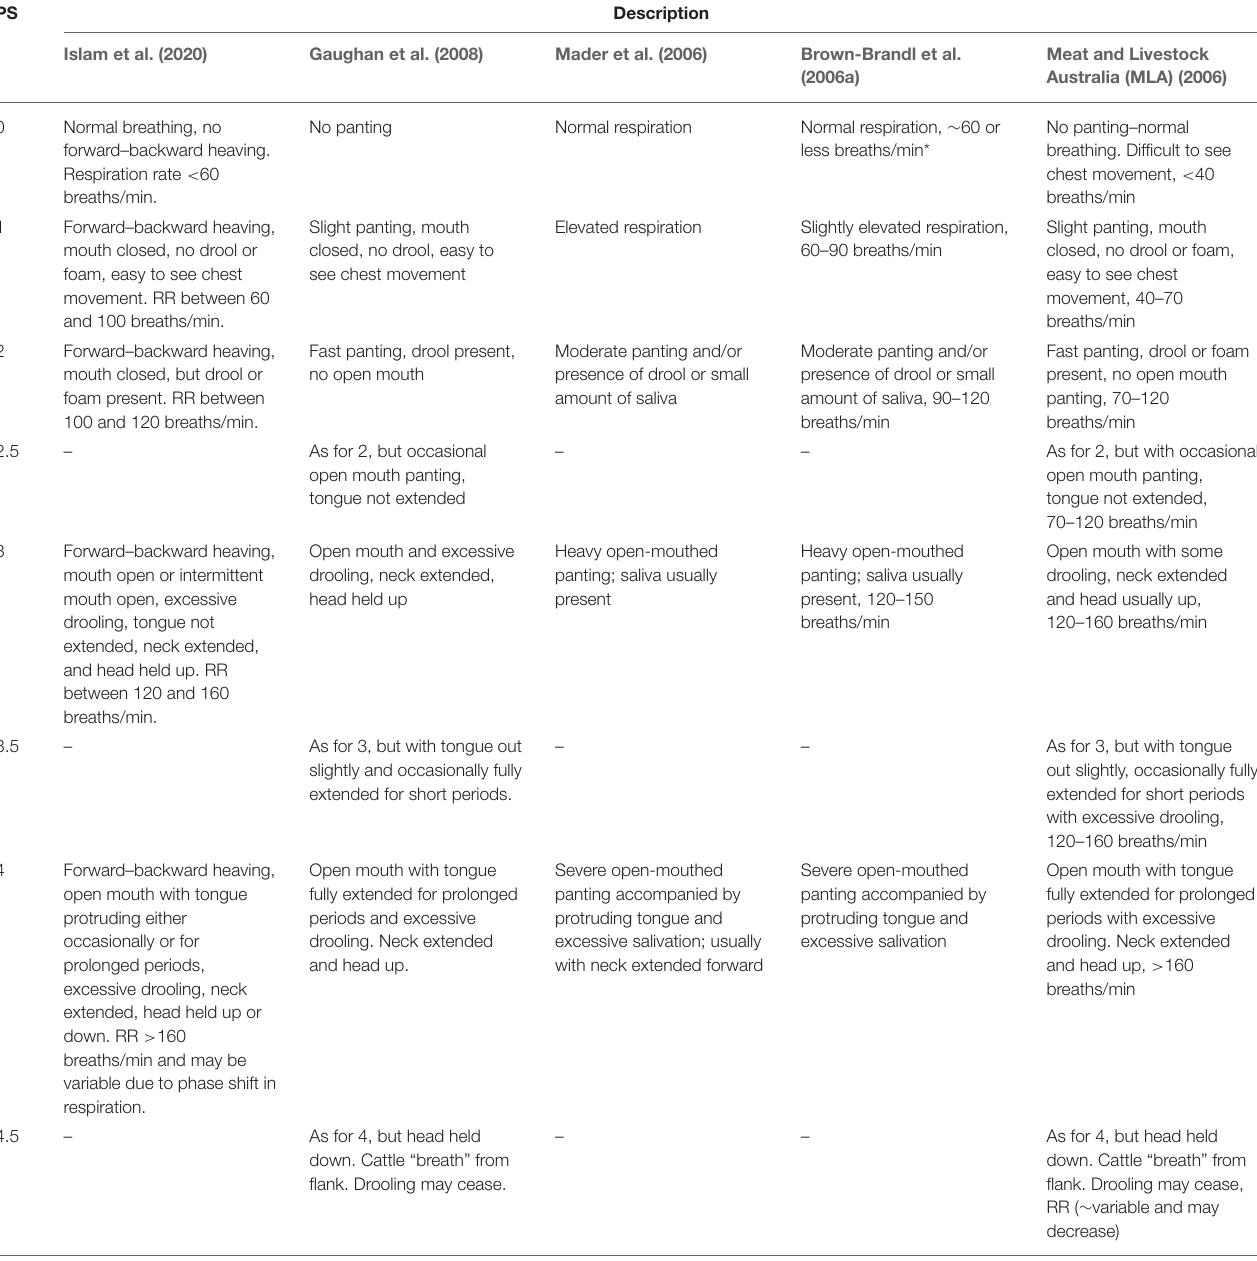
TABLE 1 | Summary of panting scores (PS) in use.